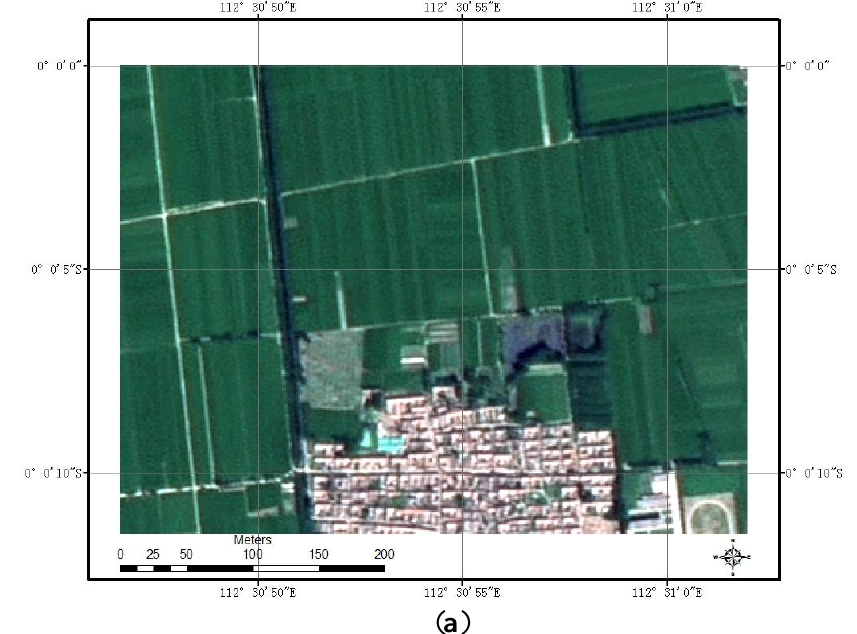
Figure 7. Another two temporal images of the same area. ( a ) t 2009. ( b ) t , image acquired in 2010. ( c ) The actual change map referenced in the 2 accuracy